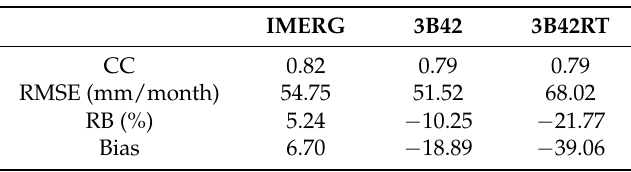
Figure 4. Monthly precipitation from gauges and three satellite precipitation products (SPPs). Table 1. Statistical metrics of monthly precipitation estimates by three SPPs. Root Mean Square Error (RMSE); Relative Bias (RB). IMERG 3B42